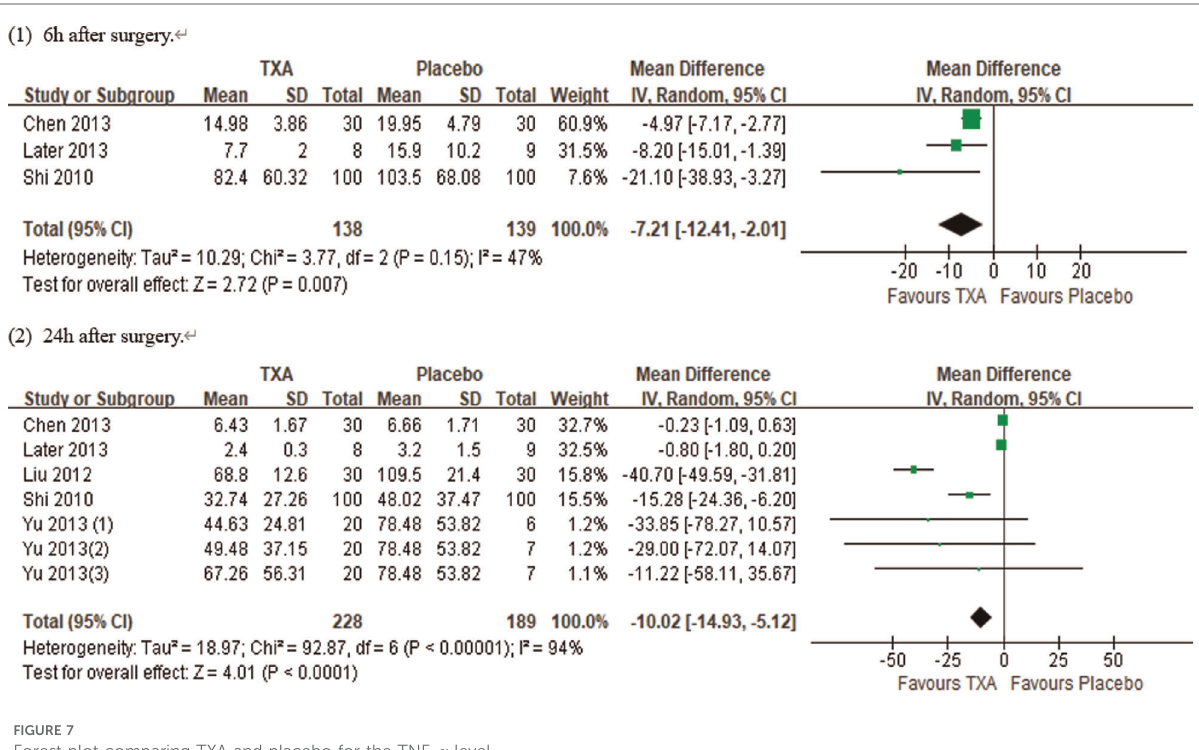
FIGURE 7 Forest plot comparing TXA and placebo for the TNF- α level.